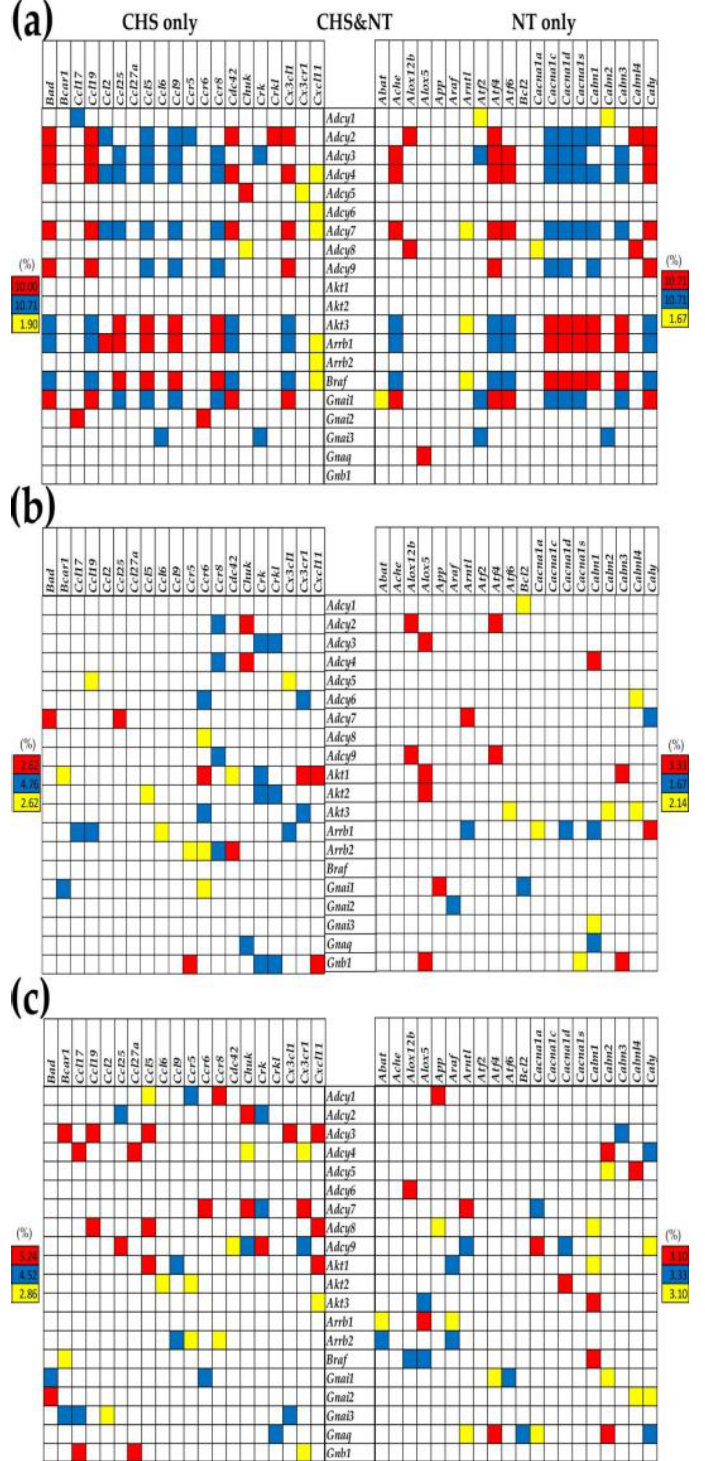
Figure 6. Transcriptomic network connecting chemokine signaling with neurotransmission genes via common genes of the two pathways in ( a ) MRL/ + , ( b ) MRL/ lpr , ( c ) Fn14ko brains. A red/blue/yellow square indicates statistically significant synergistic/antagonistic/independent expression of the genes labeling the crossing row and column. A blank square indicates not significant correlation between the expressions of the two genes.